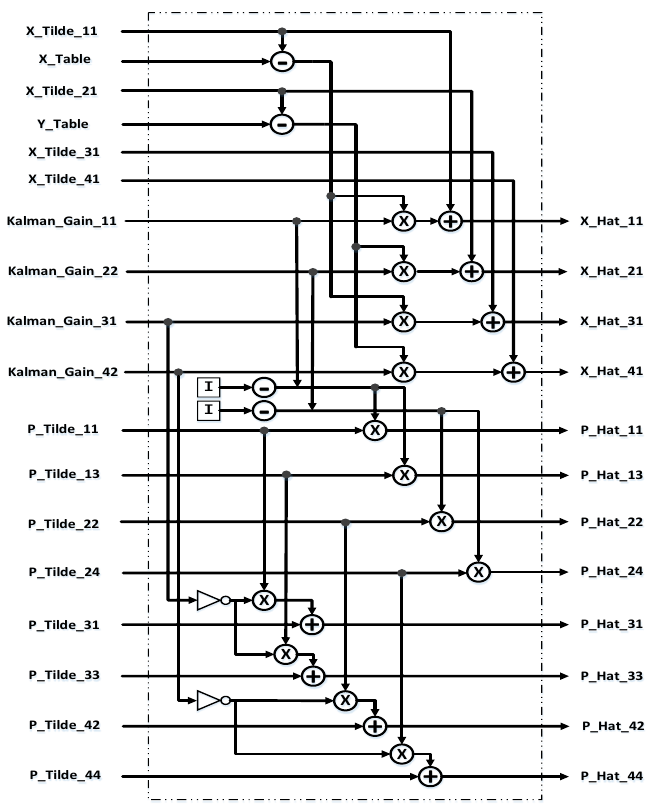
Figure 7. VLSI architecture of the update state module.